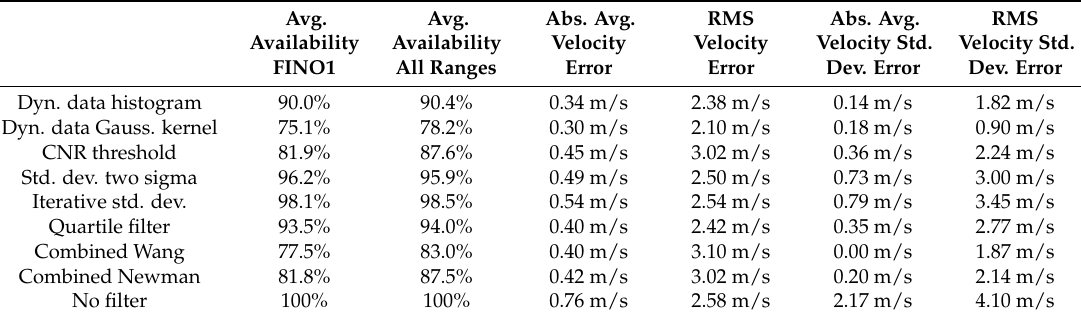
Table 1. Comparison of different filtering methods applied on staring mode measurements